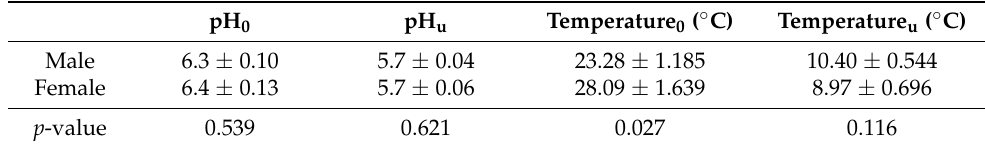
Table 2. Mean values ( ± standard errors) and least significant differences (LSD) for pH and tempera- ture for male and female red hartebeest from